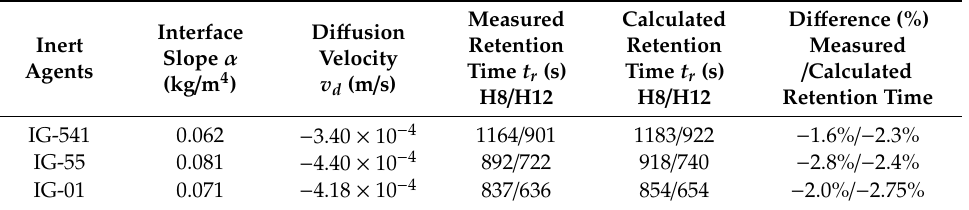
Table 7. Summary of experimental and numerical